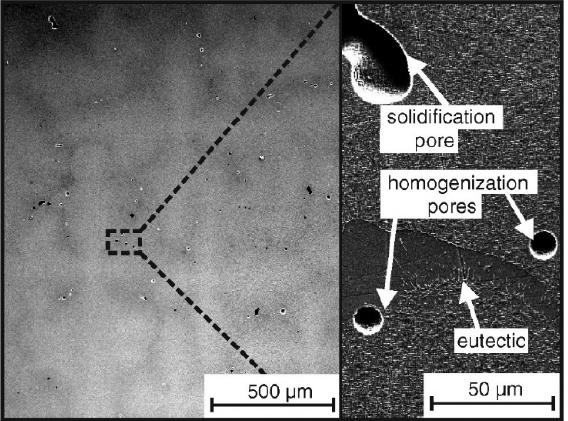
Figure 4. Morphology of micropores in SX superalloy ERBO/1 after heat treatment 1340 °C/16 h [24] .